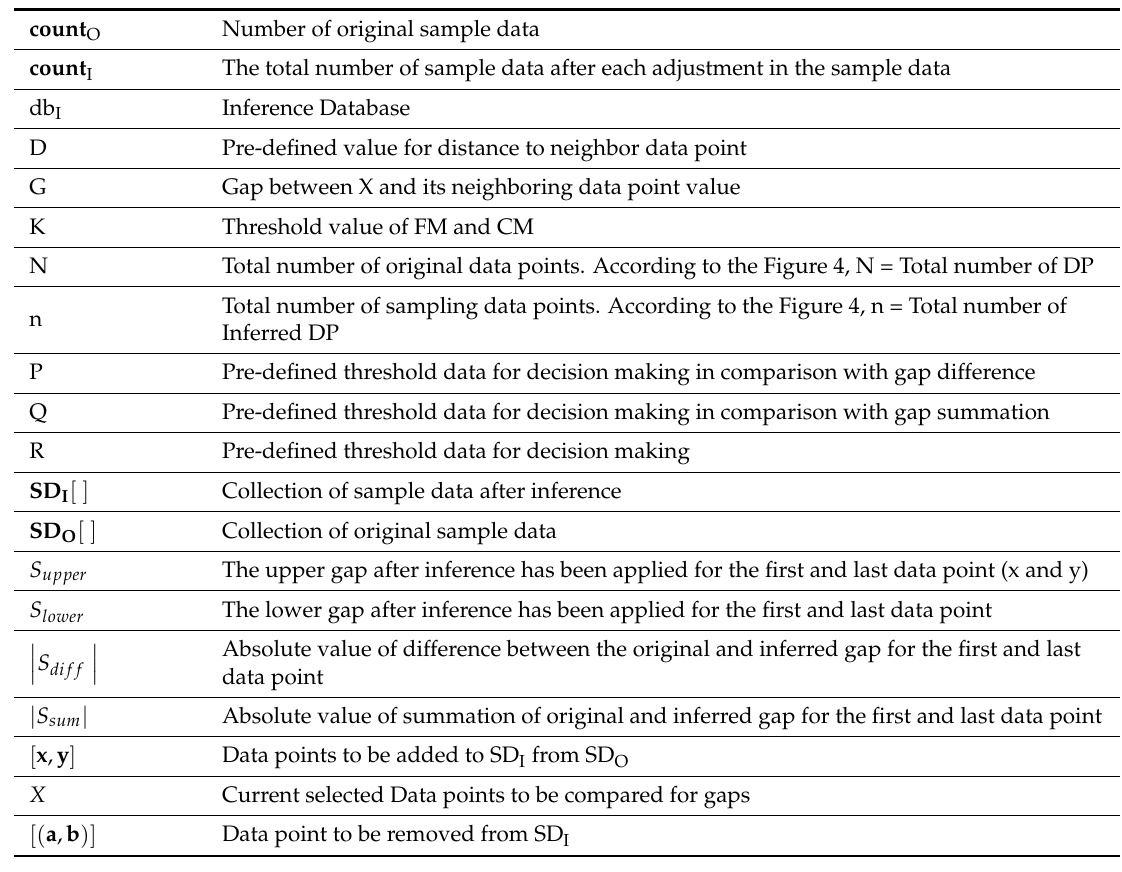
Table 1. Definitions of